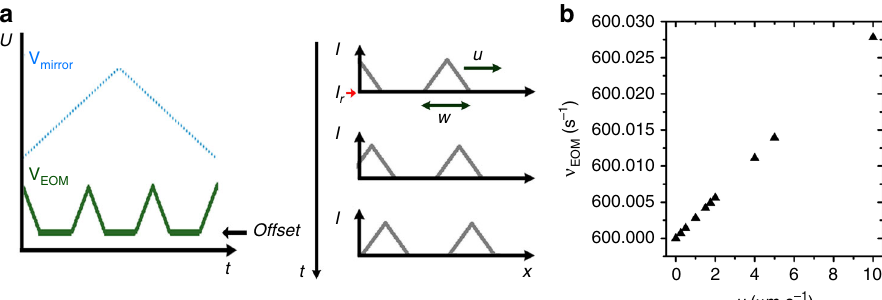
it aligns parallel with ∇ I within ~2 s (in our experiments clockwise and anticlockwise rotation is observed). The AP ’ s reorientation dynamics in an intensity gradient ∇ I is (in absence of noise) described by the differential equation (2). Solving this equation gives cos ϕ t ð Þ ¼ tanh ð ω max ð (cid:2) t (cid:2) t ÞÞ , where t is the time when ϕ (cid:2) t ð Þ ¼ π = 2 and ω max as the only fi tting parameter used to obtain the theoretical fi t in Fig. 7b and which strongly depends on ∇ I 27 . From this, one , where ϕ max is the total rotation 27 . The reorientation times given in this paper correspond to the value for ϕ = 3rad, which is shown in Fig. 7b vs. ∇ I . As a result of the heat fl ux through max the particle and its coupling to the surrounding solvent velocity at the particle surface, τ saturates at large gradients 27 . All gradients considered in this work (0.007 μ W μ m − 3 < | ∇ I |< 0.04 μ W μ m − 3 ) are above the saturation value and yield a constant reorientation time τ = 3.3± 0.75s. Creation of dynamical light patterns is achieved by a periodically oscillating mirror, which scans the elongated focus of a line-shaped (1 μ m ×2000 μ m) laser beam ( λ = 532 nm) across the sample plane. For small voltages applied to the mirror (V mirror ), the displacement of the laser line is proportional to V mirror . Synchronization of the scanning motion with the input voltage of an electro-optical modulator ( V EOM ) leads to spatio-temporal illumination patterns 27 . To generate a static light pattern, the ratio of the mirror-frequency ν mirror and the EOM- frequency ν EOM must yield a rational number, which determines the number of